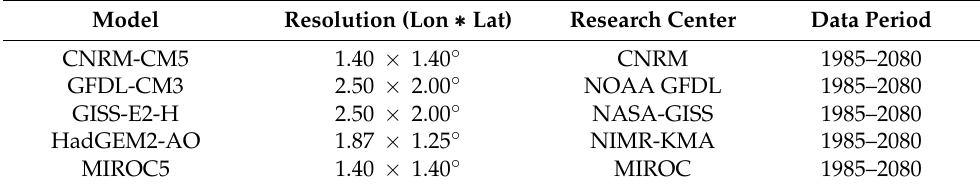
Table 3. CMIP5 rainfall and temperature data used in this study .